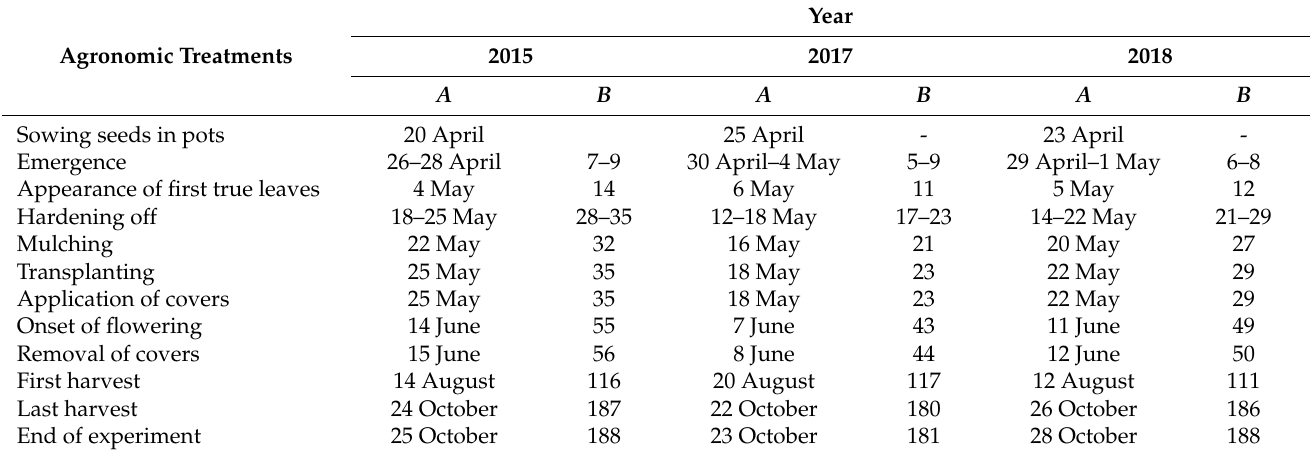
Table 2. Agronomic activities and observations in tomatillo cultivation.